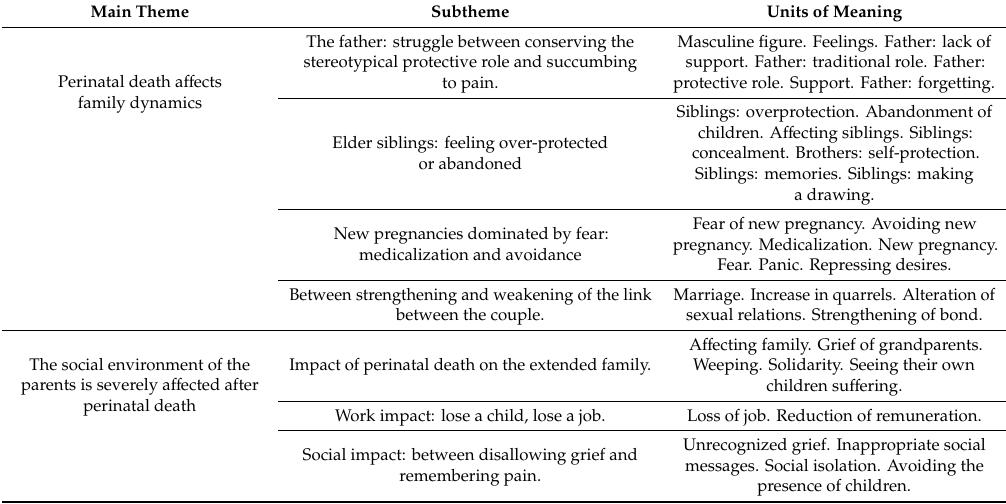
Table 4. Themes, subthemes and units of meaning.